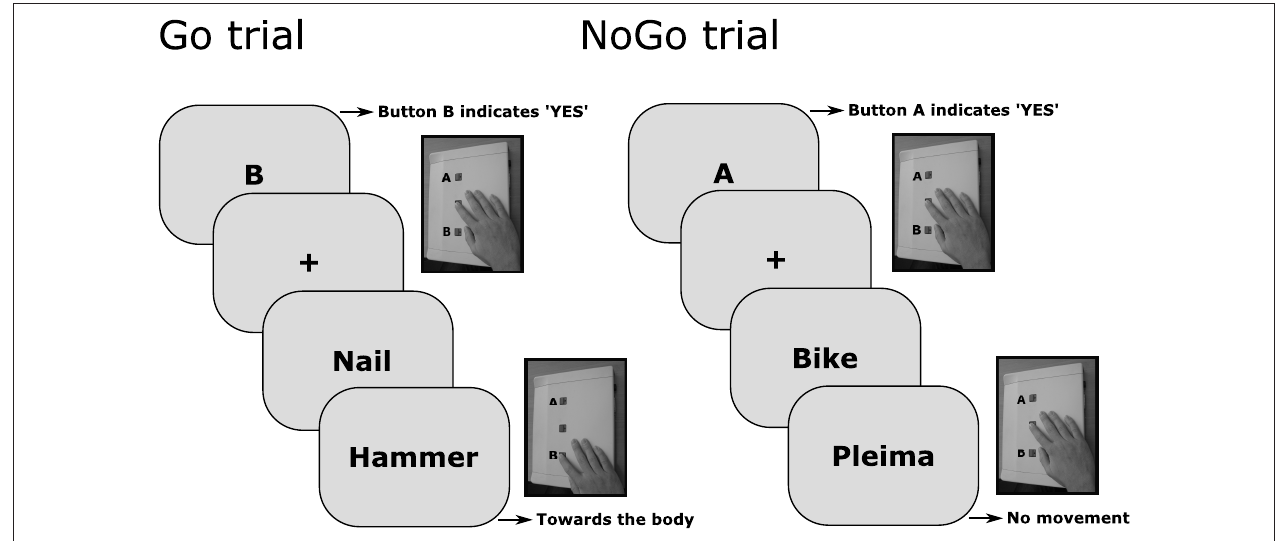
Figure 1 | illustration of a go and Nogo